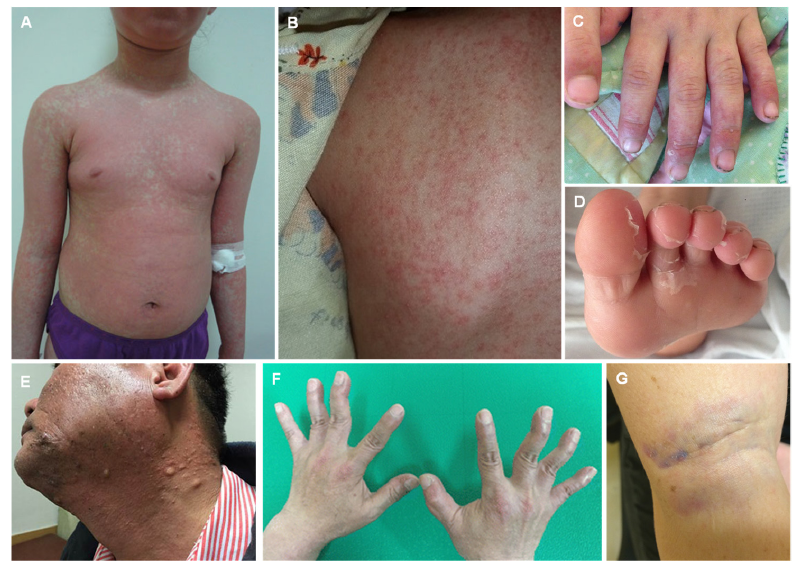
Figure 8. Dermatological manifestations of acrodynia: maculopapular rash in the trunk ( A , B ), exfoliation on fingers and pink discoloration of nails ( C ) and toes ( D ), hyperpigmentation with multiple cysts, chloracne ‐ like lesions of face and neck ( E ), swan ‐ neck deformity of both fingers ( F ), bluish gray ‐ stained area on the skin ( G ). Reprinted from ( A )—[215], ( B – D )—[268], ( E , F )—[269], ( G )—[270].